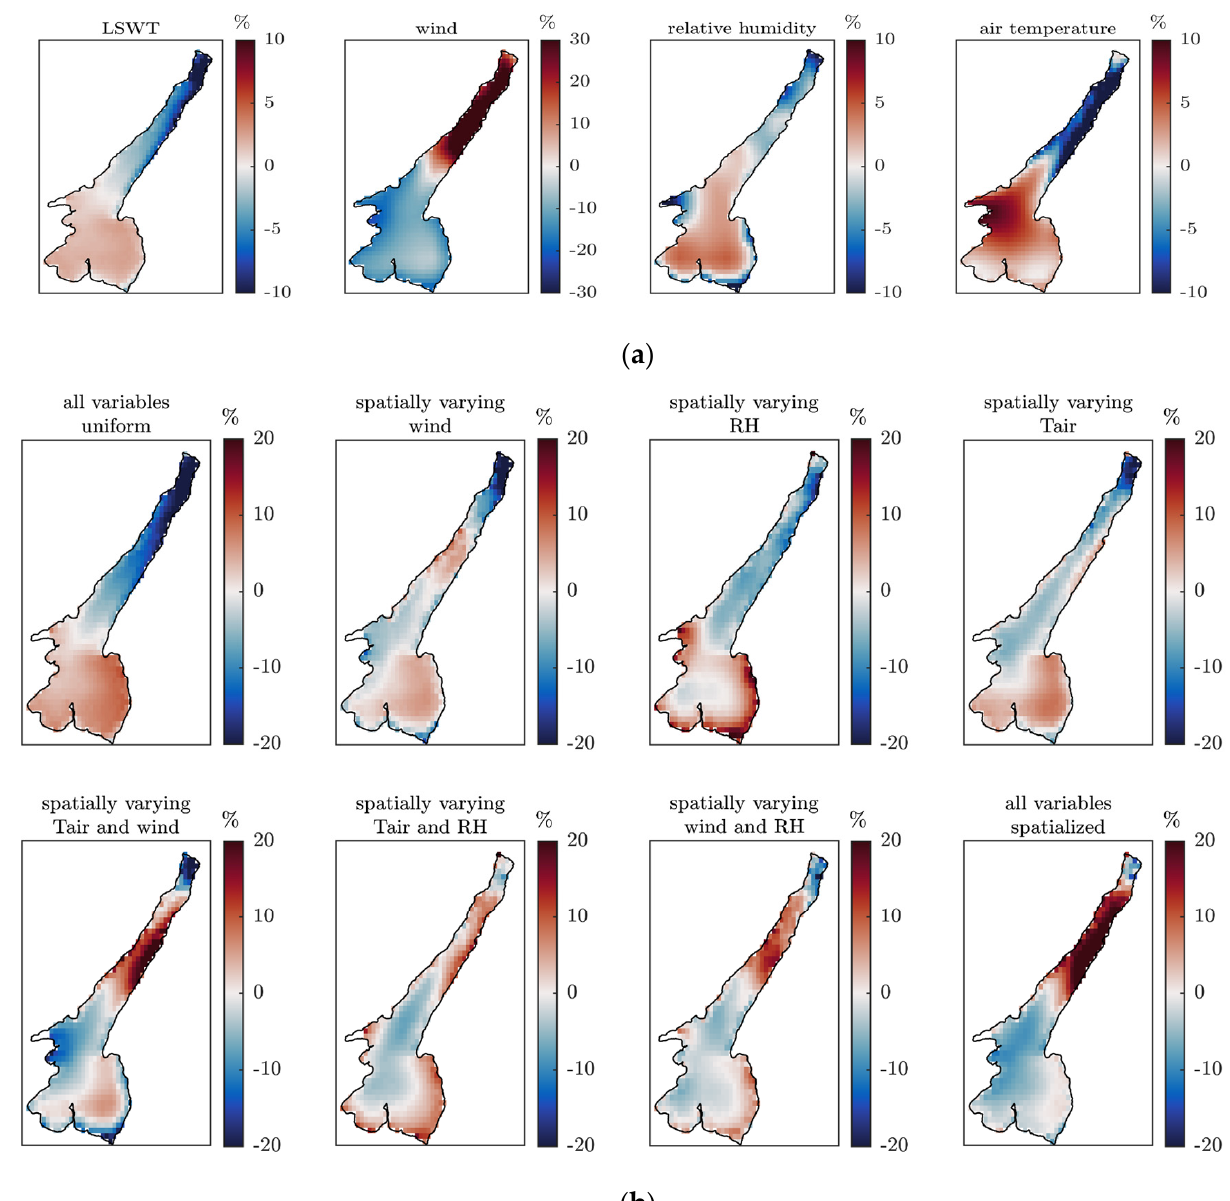
Figure 7. ( a ) Mean spatial variation of LSWT and meteorological variables used to compute E h . The percentage of variation of each quantity is obtained as a time average of the spatial anomalies normalized by the mean (in time) fields as in Equation (7). ( b ) Mean spatial variation of E h obtained by feeding the LakeVap tool with all meteorological variables as uniform in space (first panel), with single variables spatialized (panels 2–4), variables spatialized pairwise (panels 5–7), and all variables spatialized (panel 8).